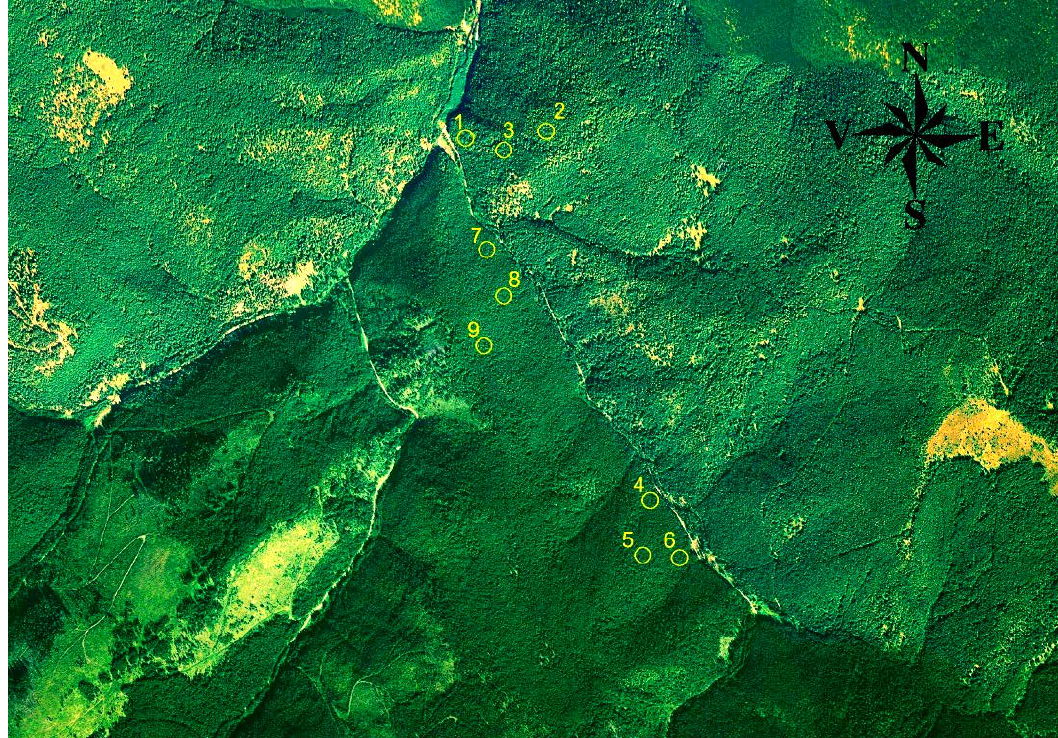
Fig. 1. The location of the spruce sample plots, depending on the local environmental